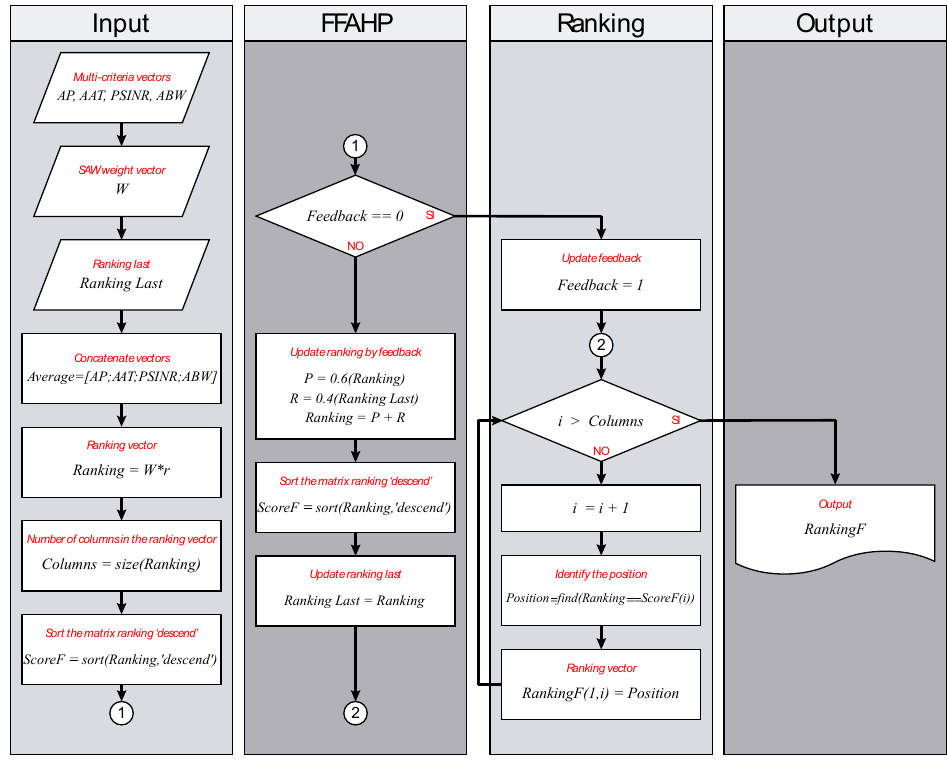
Figure 12. Feedback Fuzzy Analytical Hierarchical Process (FFAHP) algorithm flowchart.